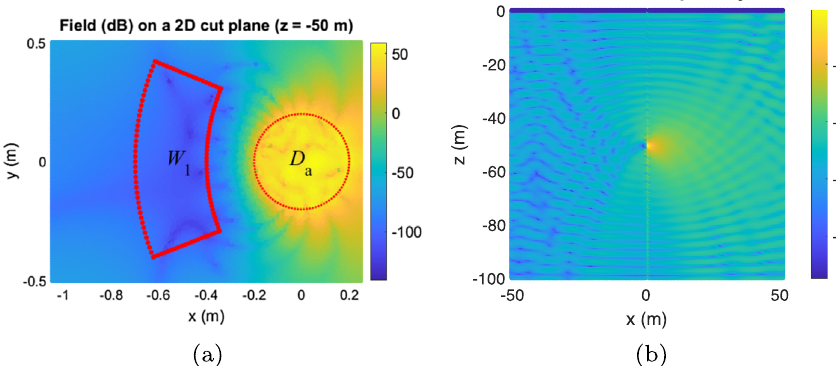
Figure 13. Generated fi elds on cut planes: (a) z = (cid:3) 50 and (b) y = 0